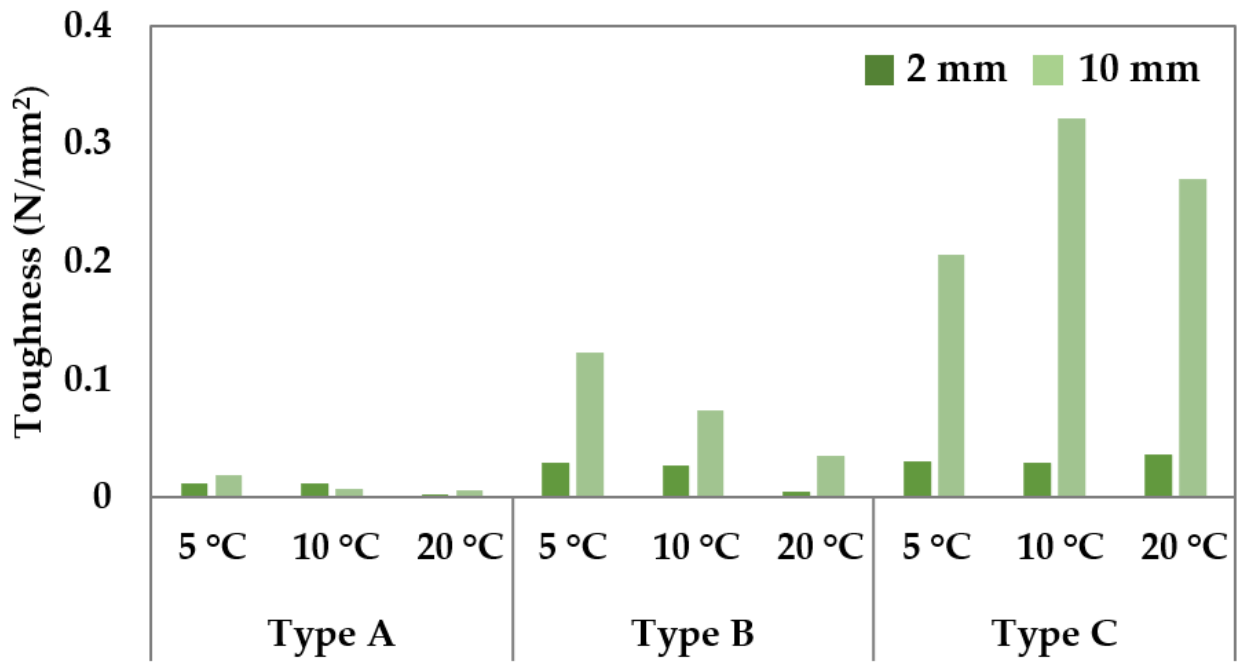
Figure 12. Toughness comparison according to thickness and temperature.